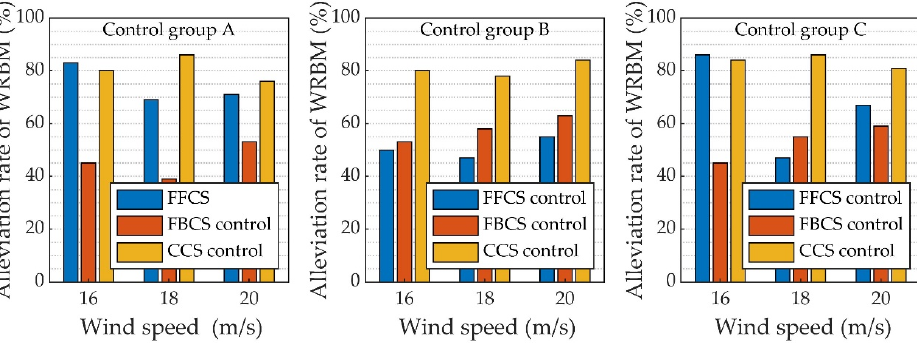
Figure 17. Comparison of WRBM alleviation rate in wind tunnel test.